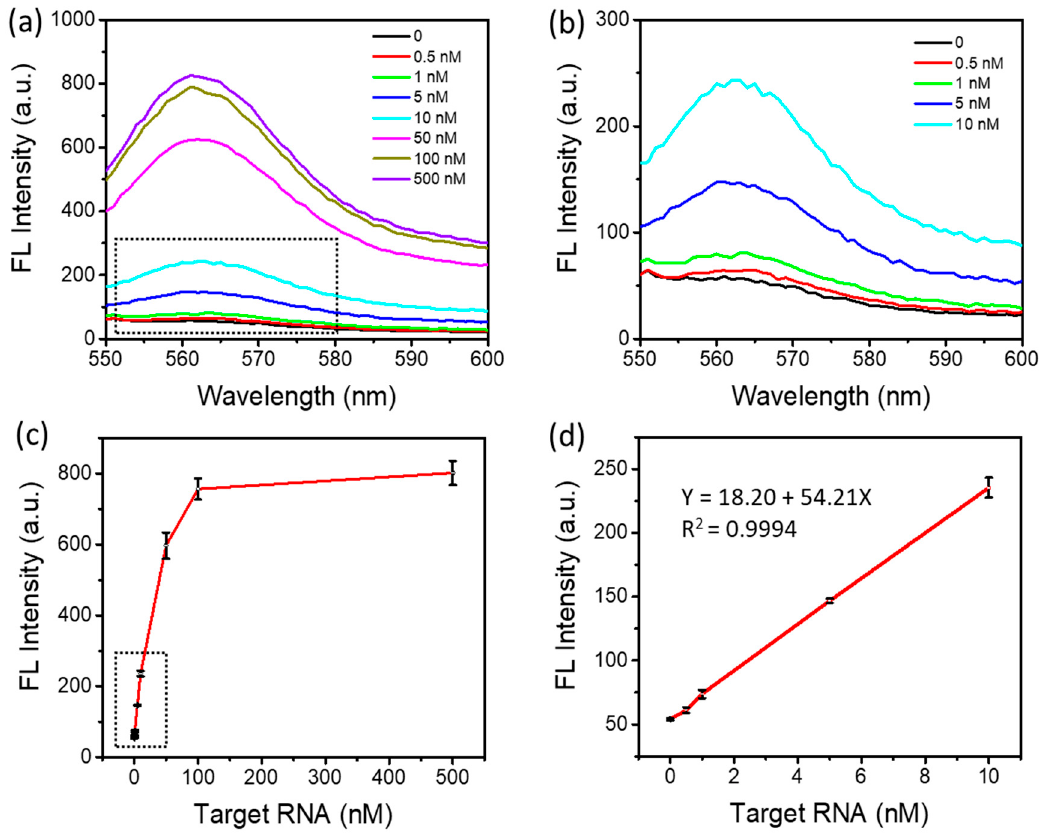
Figure 5. SARS-CoV-2 RNA detection. ( a ) Fluorescence emission spectra with different target RNA concentrations. ( b ) An enlarged view of the black dotted box in ( a ) representing the fluorescence responses to target RNA at low concentrations. ( c ) Fluorescence intensity depending on the concentrations of target RNA. ( d ) Linear relationship between fluorescence intensity and the concentration of target RNA, an enlarged view of the black dotted box in ( c ).